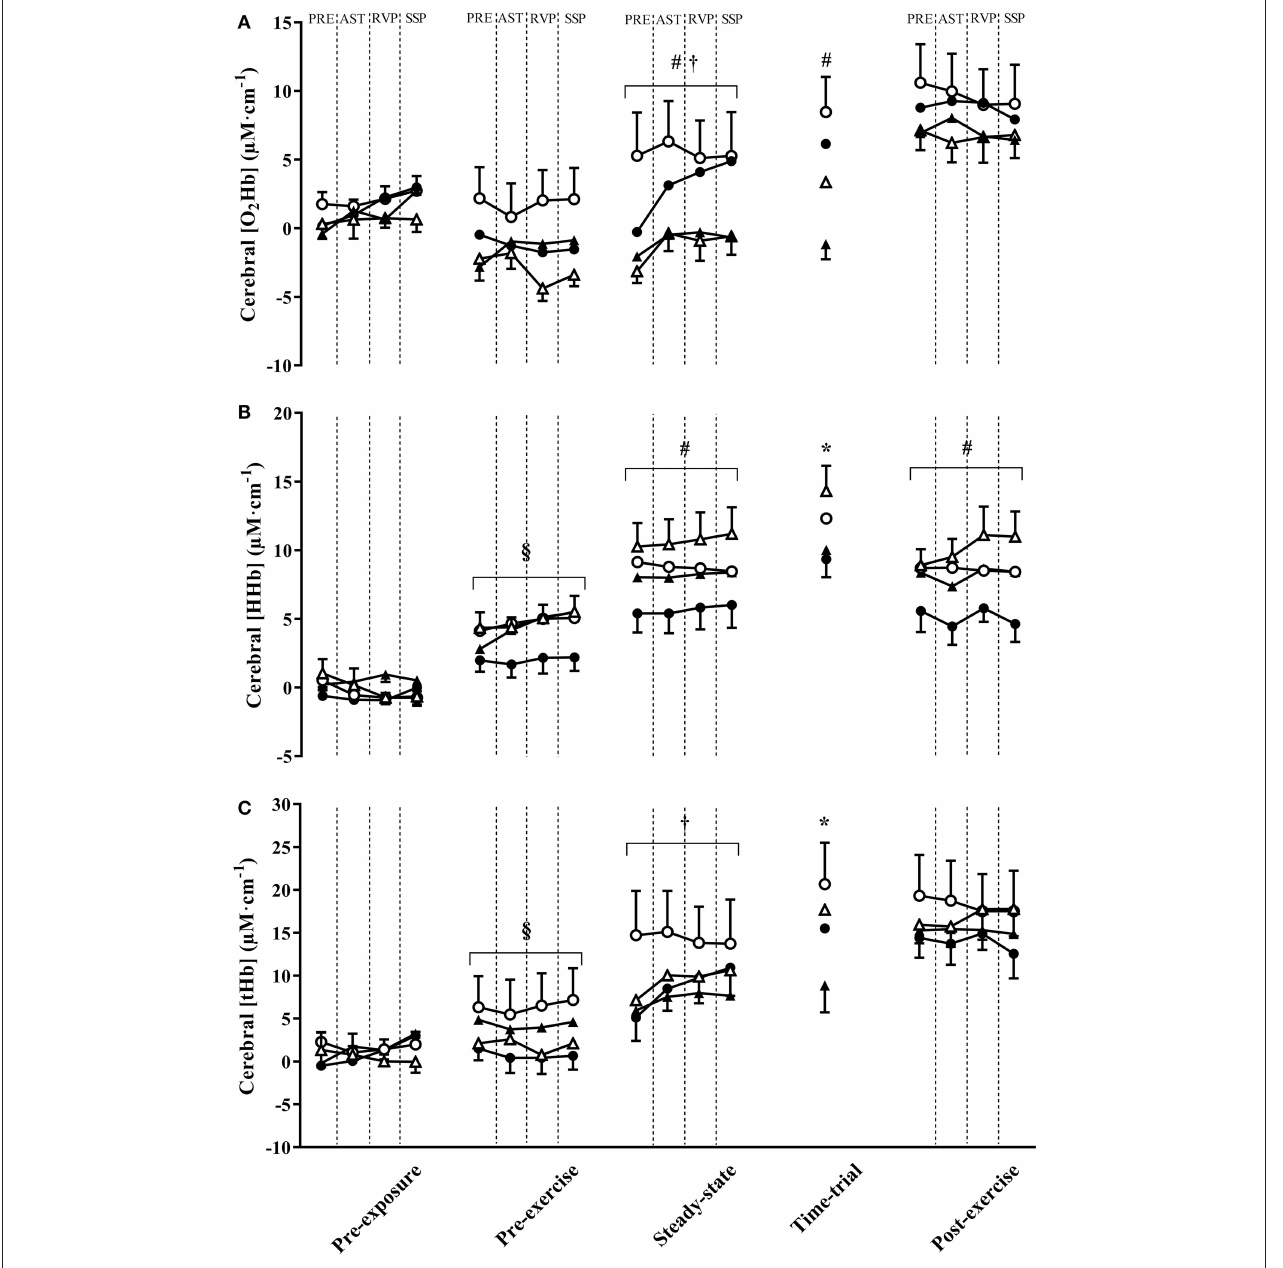
FIGURE 4 | The change in cerebral oxyhaemoglobin concentration ([HbO 2 ]) (A) , deoxyhaemoglobin concentration ([HHb]) (B) , and total hemoglobin concentration ([tHb]) (C) throughout experimental trials at 3,000 and 4,300m simulated altitude following nitrate-rich beetroot juice (BRJ) and nitrate-deplete placebo (PLA) supplementation. Values were obtained in the 5 min prior to cognitive tasks (PRE), and during the Attention Switching Task (AST), Rapid Visual Information Processing Task (RVP), and Spatial Span Task (SSP). Closed circles, BRJ-3000m; open circles, PLA-3000m; closed triangles, BRJ-4300m; open triangles, PLA. Data are presented as mean and SEM. 4300m *Significant main effect of supplement ( p < 0.05). # Significant main effect of altitude ( p < 0.05). † Significant main effect of task ( p < 0.05). § Significant supplement x altitude interaction ( p <